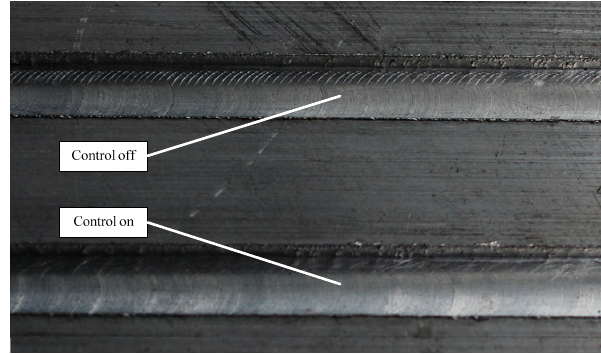
Figure 11. Machining effect of the aluminium plate with and without on-line vibration suppression.